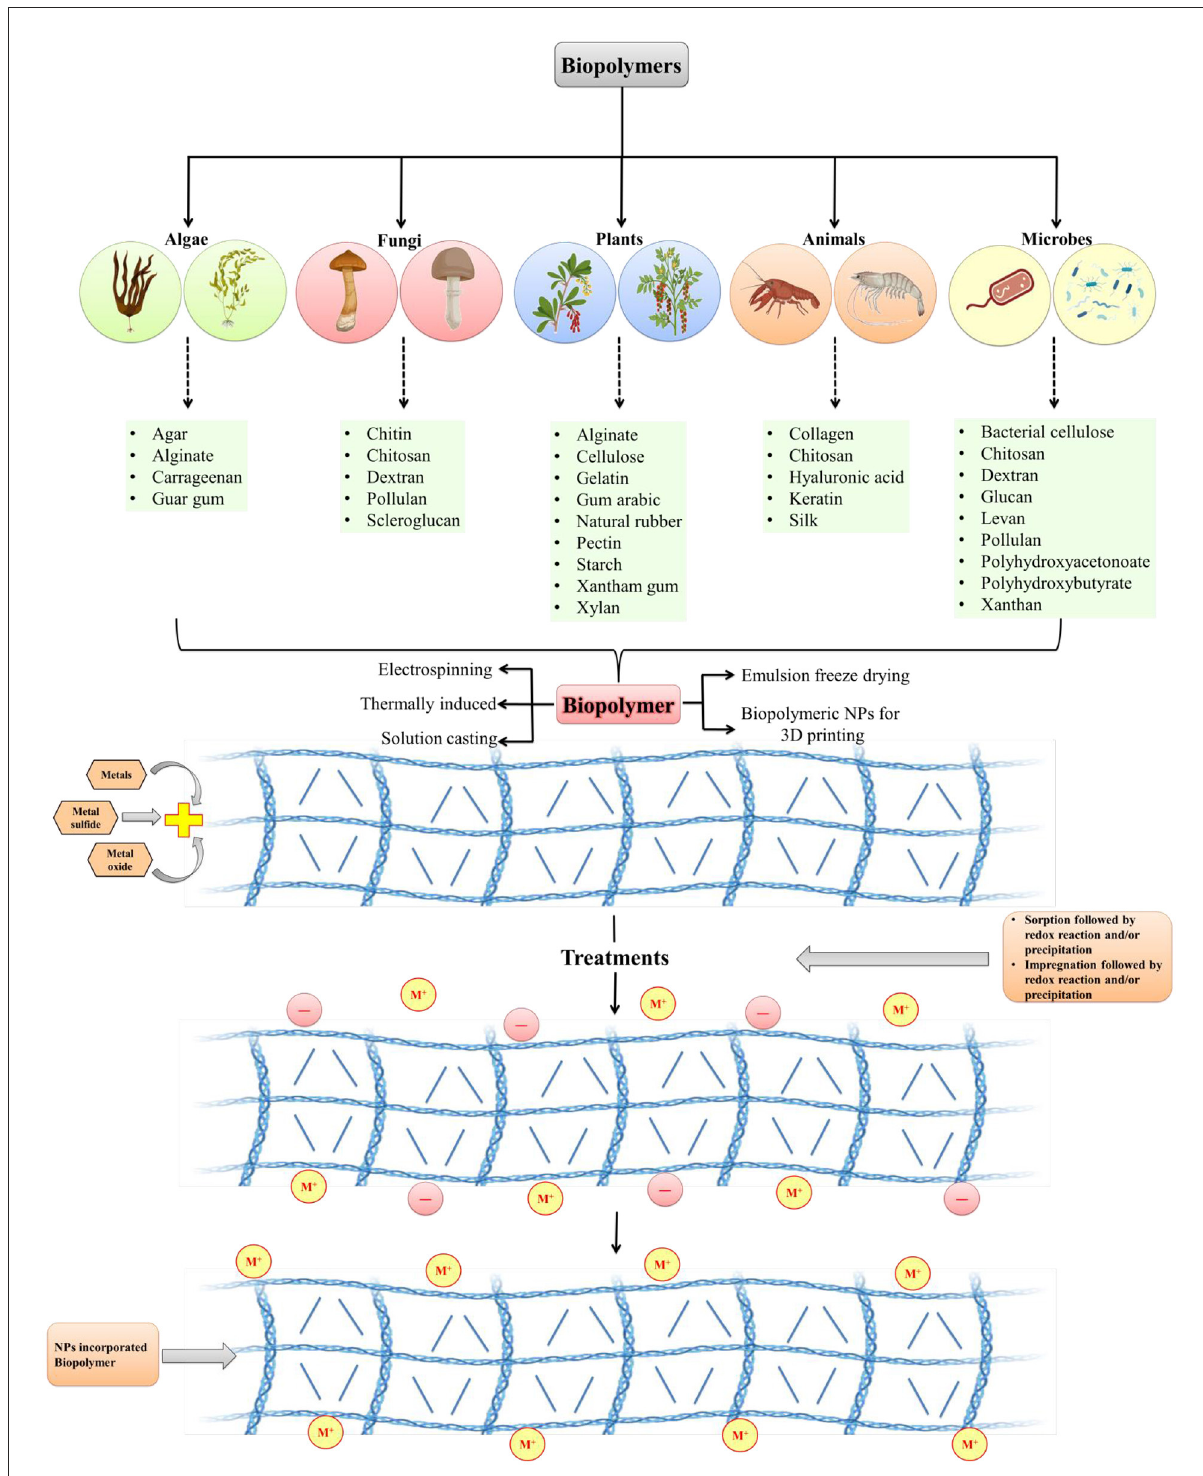
FIGURE1 Development of biopolymeric nanoparticles from various sources (modified and adapted from Sarkar et al. (57).